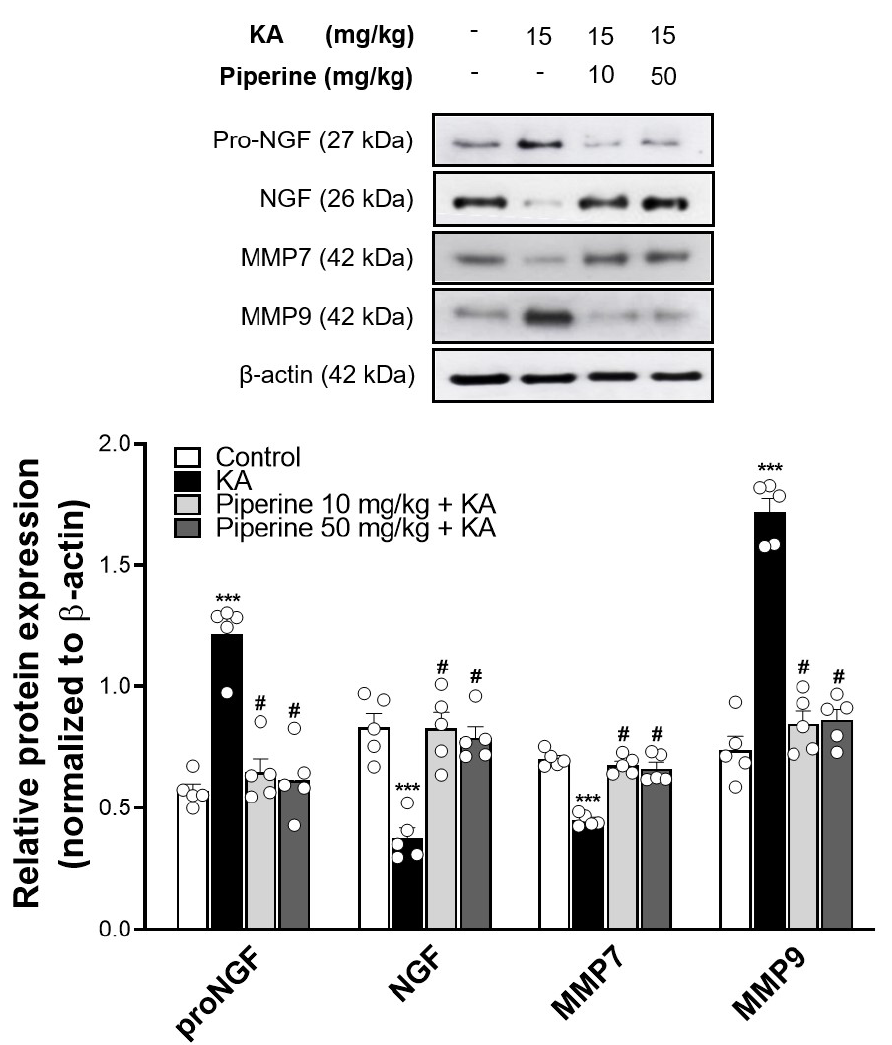
Figure 5. Effect of piperine pretreatment on pro-NGF, NGF, MMP7, and MMP9 protein levels in the hippocampus of KA-treated rats. The upper panels show representative Western blots. The lower panel is the relative density bar graph. Quantification of each protein was normalized to β-actin. Data are presented as the means ± S.E.M. (n = 5). # p < 0.001 versus the KA group; *** p < 0.001 versus the control group (ANOVA/Scheffé).